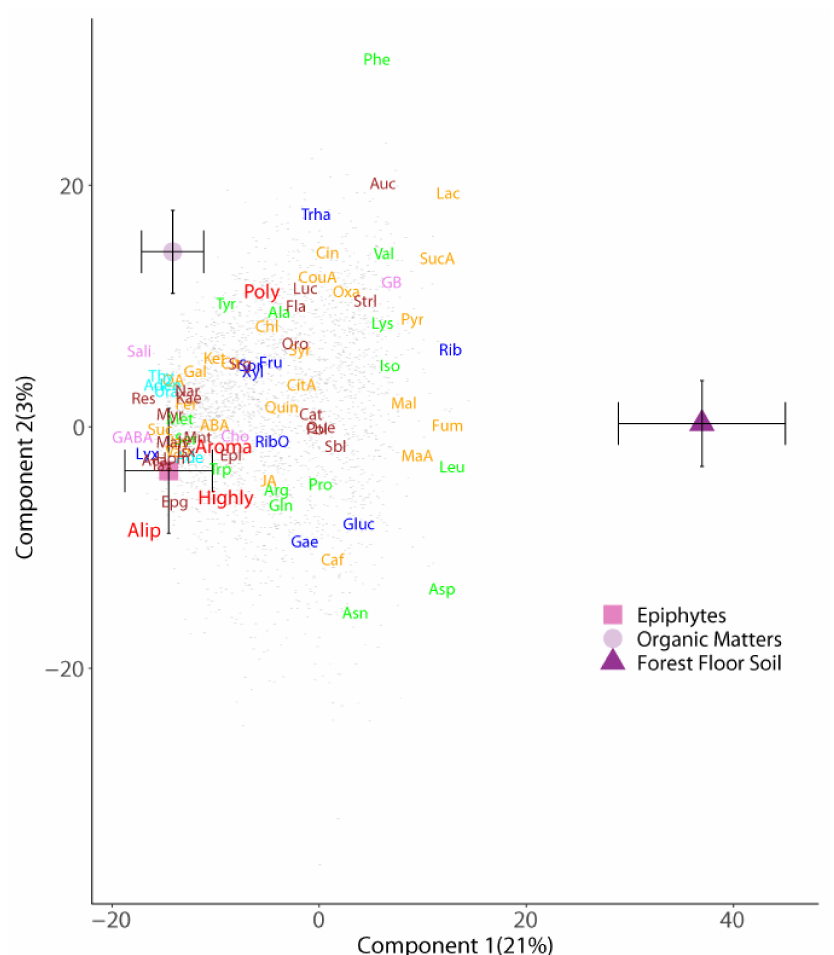
Figure 1. Partial least squares discriminant analysis biplots of metabolomic profiles of forest floor soils and epiphyte-associated and non-associated suspended soils (organic matter). Depicted values are means ( ± 95% CI). Samples’ categorized scores (mean ± S.E.) by different soil types: “Epiphytes” (suspended soils associated with an epiphyte), “Organic Matters” (canopy soil without an epiphyte), and “Forest Floor Soil”. Soils are indicated by different colors: pink square, epiphytes; lilac circle, or- ganic matters; purple triangle, forest floor soil. Loadings of the metabolites; only those with loadings >0.5 are depicted. The various metabolomic families are represented by different colors: dark blue, sugars; green, amino acids; orange, compounds involved in the metabolism of amino acids and sug- ars; cyan, nucleotides; brown, phenolics; red, others. Metabolites: arginine (Arg), asparagine (Asn), aspartic acid (Asp), glutamic acid (Glu), glutamine (Gln), isoleucine (Ile), lysine (Lys), leucine (Leu), methionine (Met), phenylalanine (Phe), serine (Ser), tryptophan (Trp), threonine (Thr), tyrosine (Tyr), valine (Val), adenine (Ade), adenosine (Ado), thymidine (TdR), chlorogenic acid (CGA), trans-caffeic acid (CafA), α -ketoglutaric acid (KG), citric acid (Cit), L-malic acid (Mal), lactic acid (Lac), abscisic acid (Abs), pyruvate (Pyr), succinic acid (SAD), pantothenic acid hemicalcium salt (Pan), jasmonic acid (JA), 5,7-dihydroxy-3,4,5–trimethoxyflavone (Fla), acacetin (AC), epicatechin (EC), epigallocat- echin (EGC), homoorientin (Hom), isovitexin (Ivx), kaempferol (Kae), myricetin (Myr), quercetin (Qct), resveratrol (Rvt), saponarin (Sp), catechin hydrate (Cat), 3-coumaric acid (CouA), gallic acid (GA), quinic acid (QuiA), sodium salicylate (Sal), syringic acid (Syr), trans-ferulic acid (Fer), vanillic acid (Van), 2-deoxy-D-ribose (Rib), D-(-)-lyxose (Lyx), D-(+)-sorbose (Sor), D-(+)-trehalose dehydrate (Tre), aucubin (Auc). All the other small grey dots correspond to non-identified